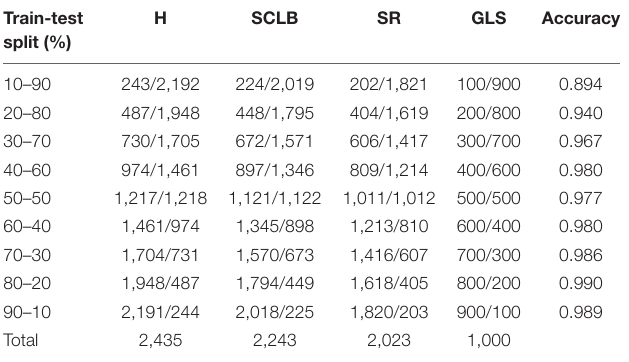
TABLE 4 | The standard model accuracy results for each train-validation set.